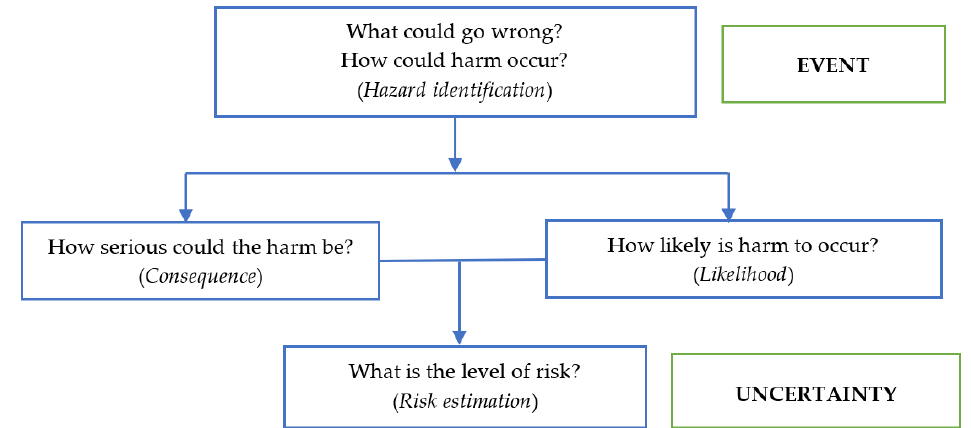
Figure 1. The framework of risk assessment on the release of Wolbachia -infected Aedes aegypti in Yogyakarta,